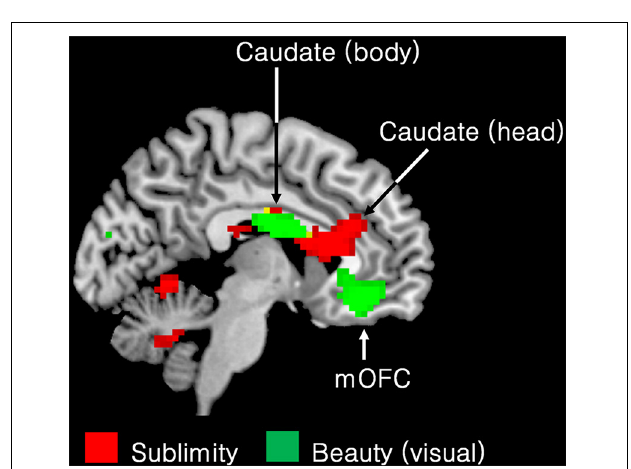
FIGURE 4 | Superimposed functional maps to show brain areas whose activity correlates with the experience of visual beauty (Ishizu and Zeki, 2011) (green) and the ones in which activity correlates with experience of the sublime (this study, red). Activity in the body of the caudate nucleus ( − 9 − 1 25) and in the medial obito-frontal cortex (mOFC) ( − 6 41 − 11) correlates with the experience of visual beauty whereas activity in the head of the caudate, encroaching on anterior cingulate cortex, correlates with experience of the sublime (9 23 16). Both activations are presented using p < 0 . 001 uncorrected